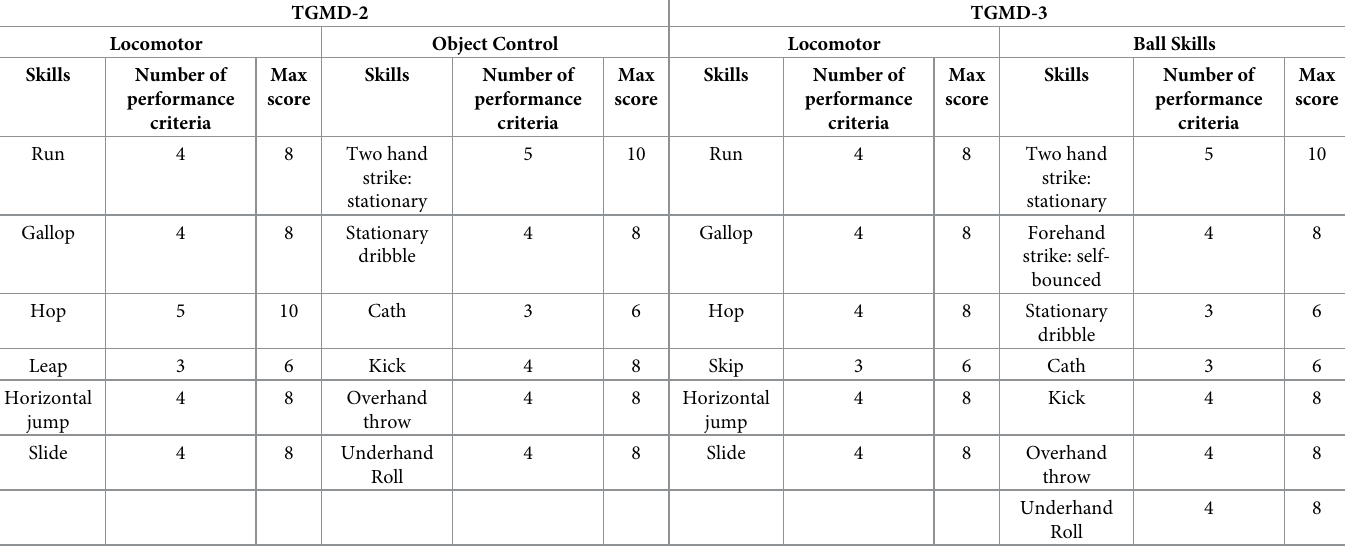
Table 1. TGMD-2 and TGMD-3 subscales, skills, performance criteria, and